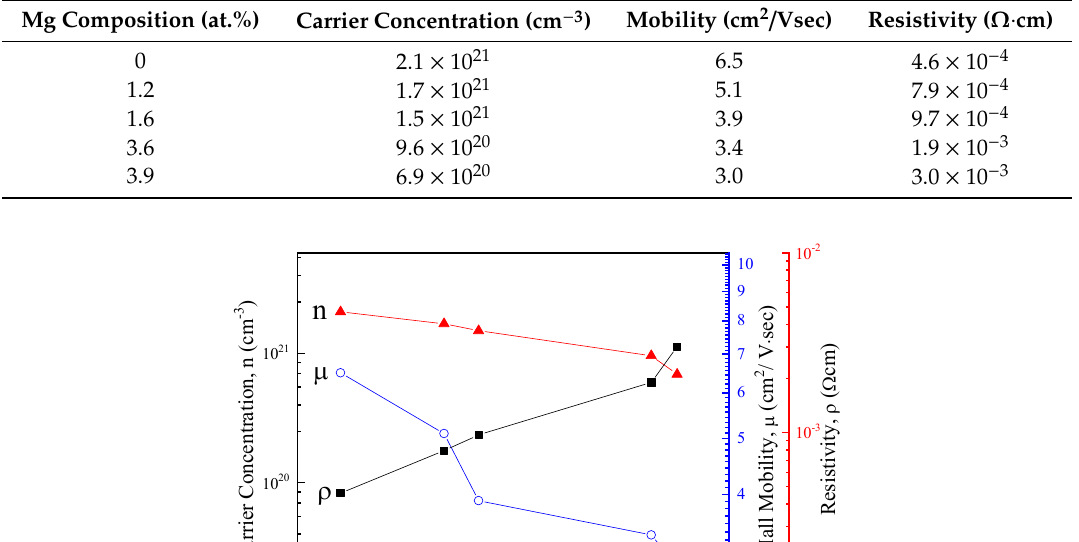
Table 2. Electrical properties of the films annealed at 600 °C.